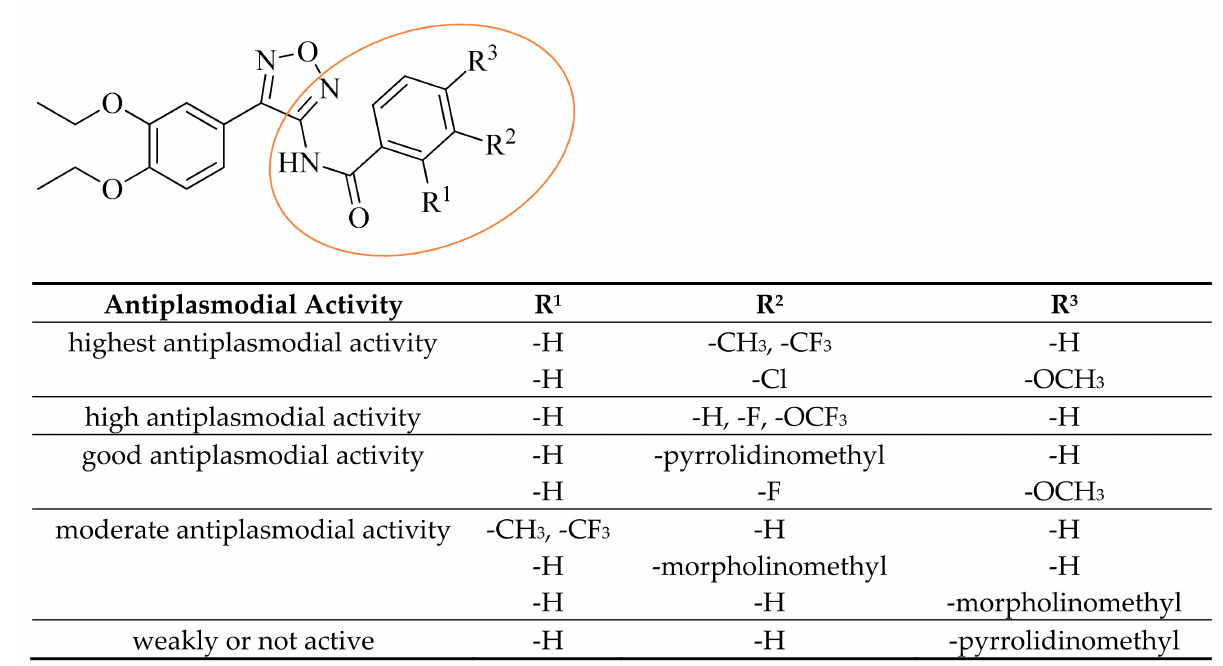
Scheme 6. Summary of SARs of benzoyl